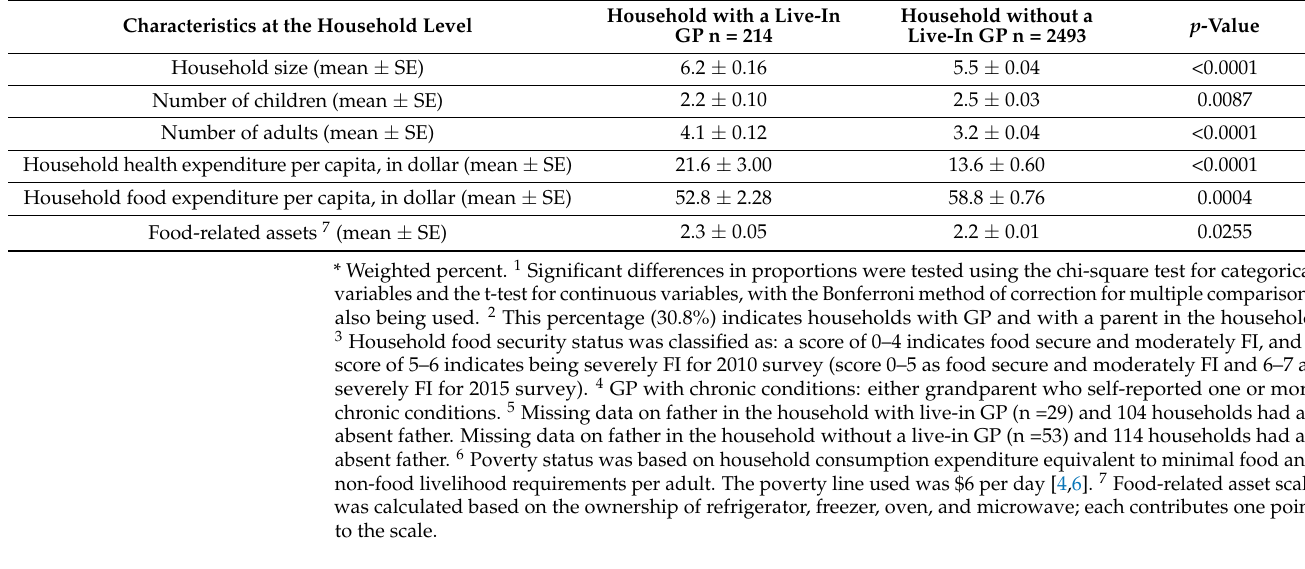
Table 3. Sociodemographic and economic characteristics of children living in a household with and without a live-in grandparent (GP), (2010 and 2015 Socio-Economic Surveys of Palestinian Refugees in Lebanon). * 1